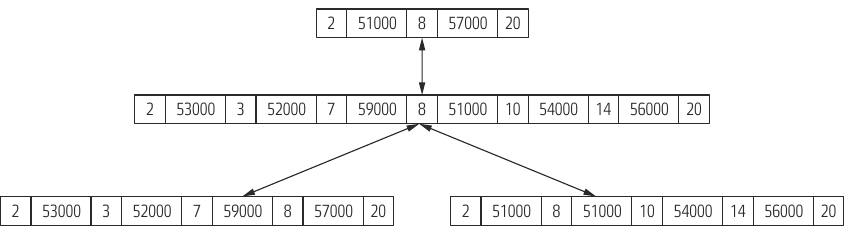
Figure 2. A single point crossover operation (at node 8)